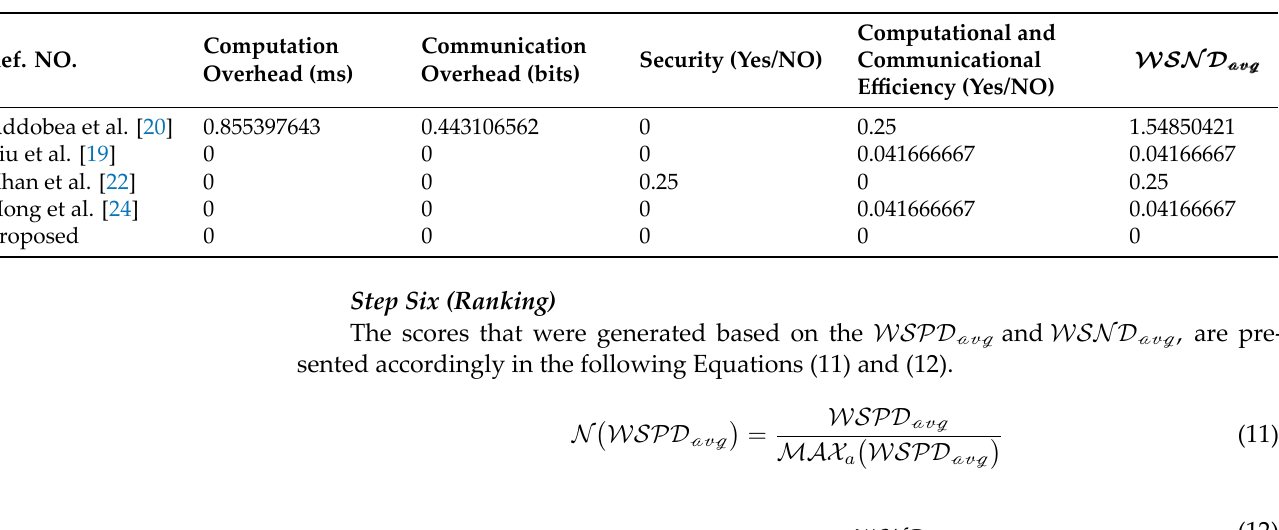
Table 13. Weighted sum of the negative